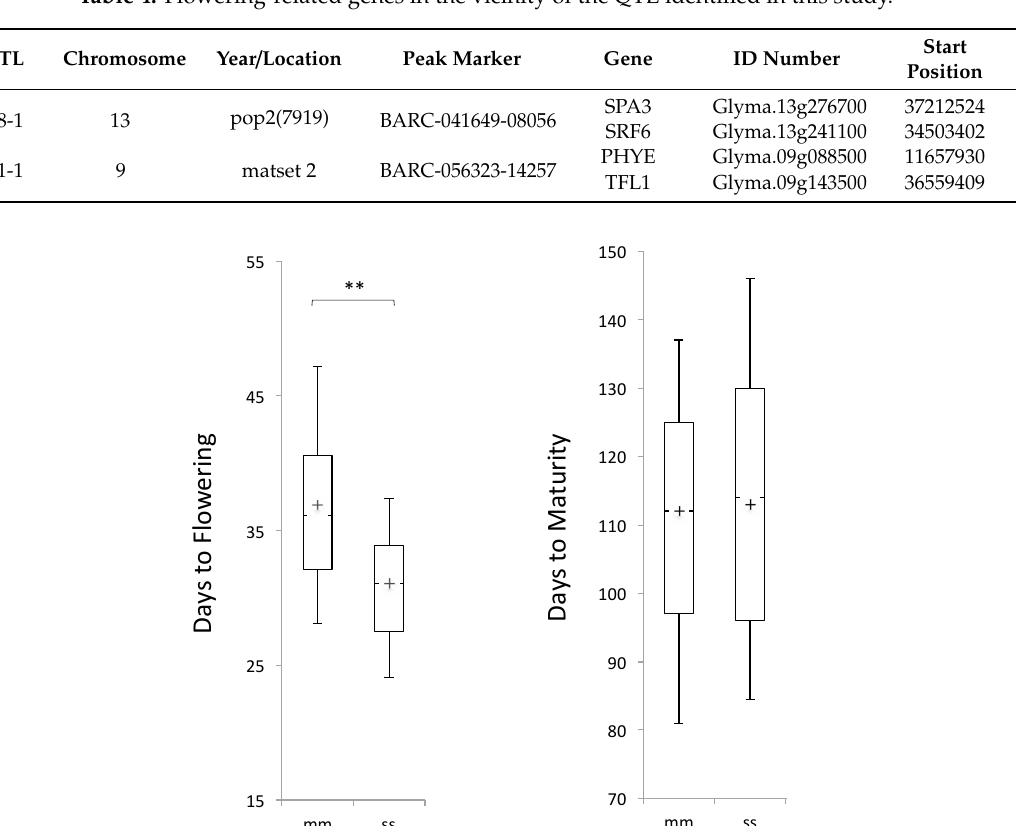
Table 4. Flowering-related genes in the vicinity of the QTL identified in this study.